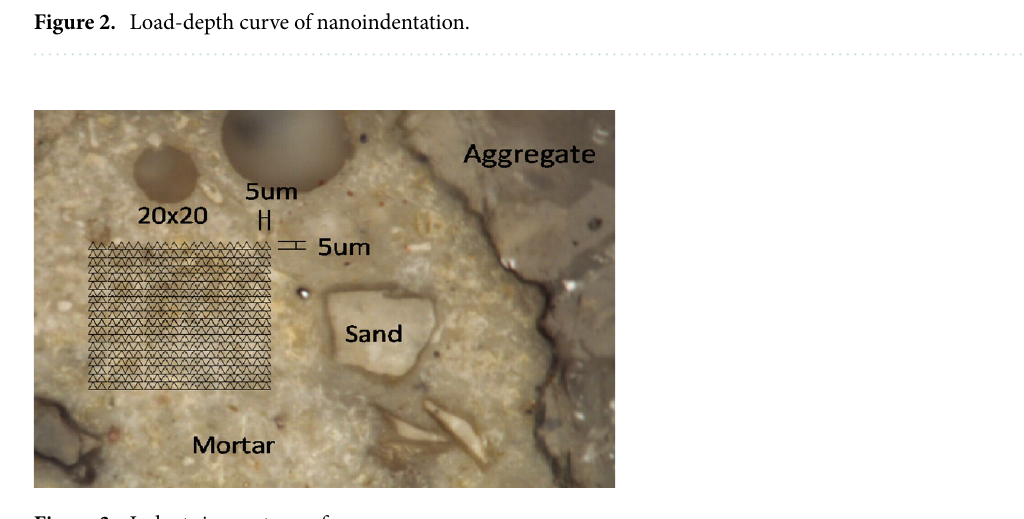
Figure 3. Indents in mortar